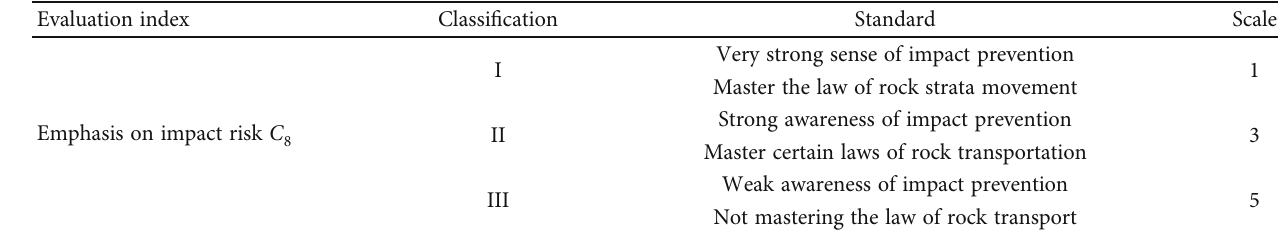
Table 11: Classi fi cation standard of shock risk attention degree.